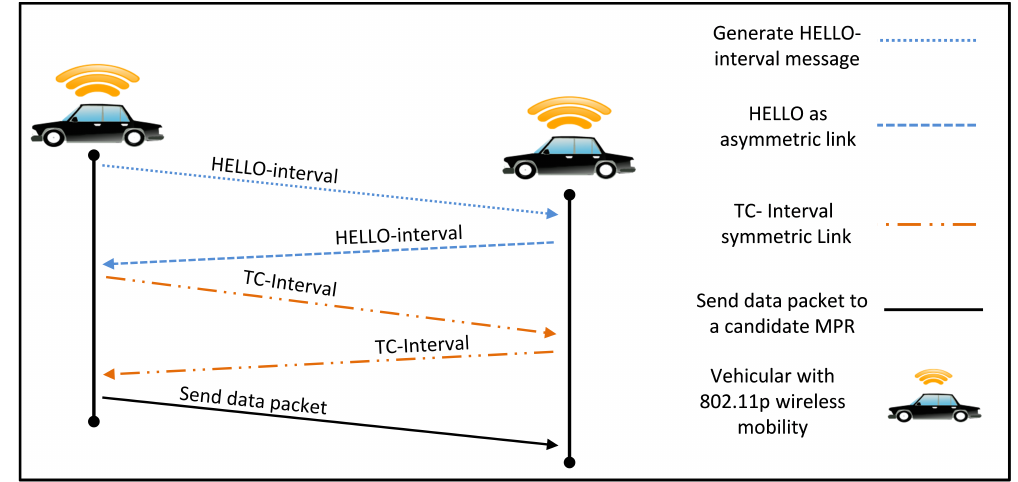
Figure 4. Communications Mode Between Two Pairs of